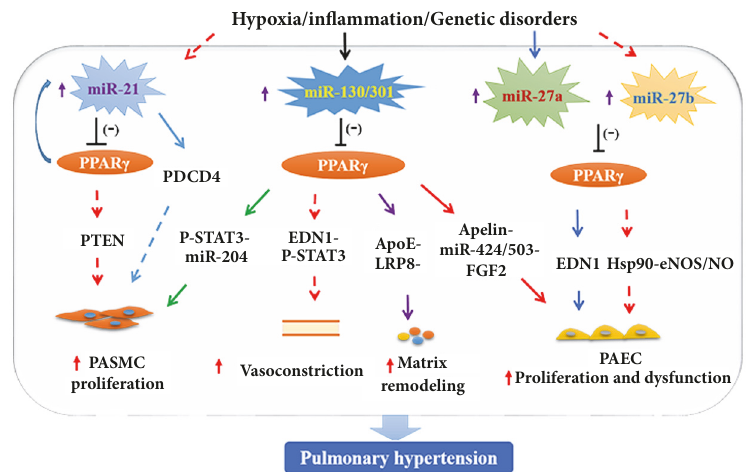
Figure 1: The regulation of peroxisome proliferator-activated receptors (PPARs) by microRNAs in pulmonary hypertension. PASMC: pulmonary arterial smooth muscle cells; PAEC: pulmonary arterial endothelial cells; PTEN: phosphatase and tensin homolog deleted on chromosome 10; PDCD4: programmed cell death 4; STAT3: signal transducer and activator of transcription 3; EDN1: endothelin-1; APOE: